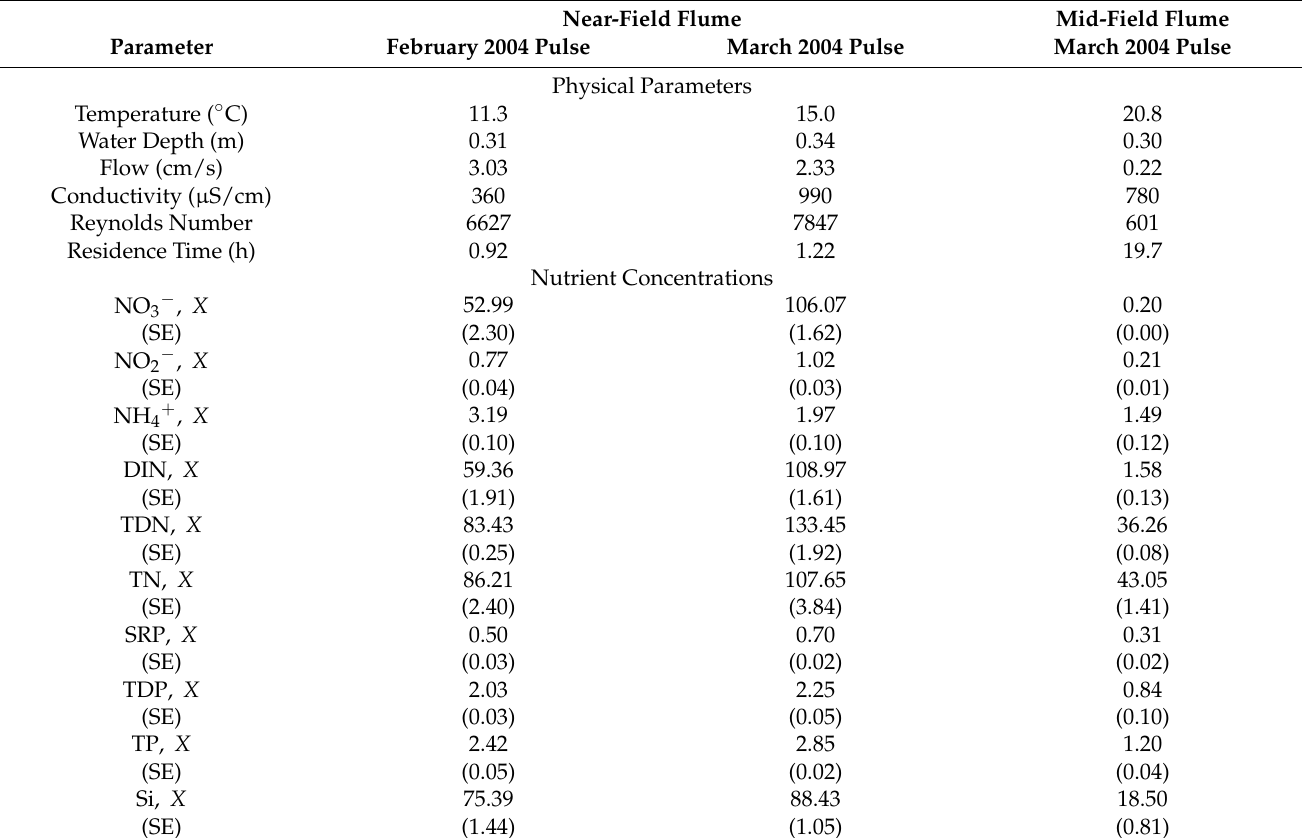
Table 4. Parameters in the Near-field and Mid-field flumes during the February and March